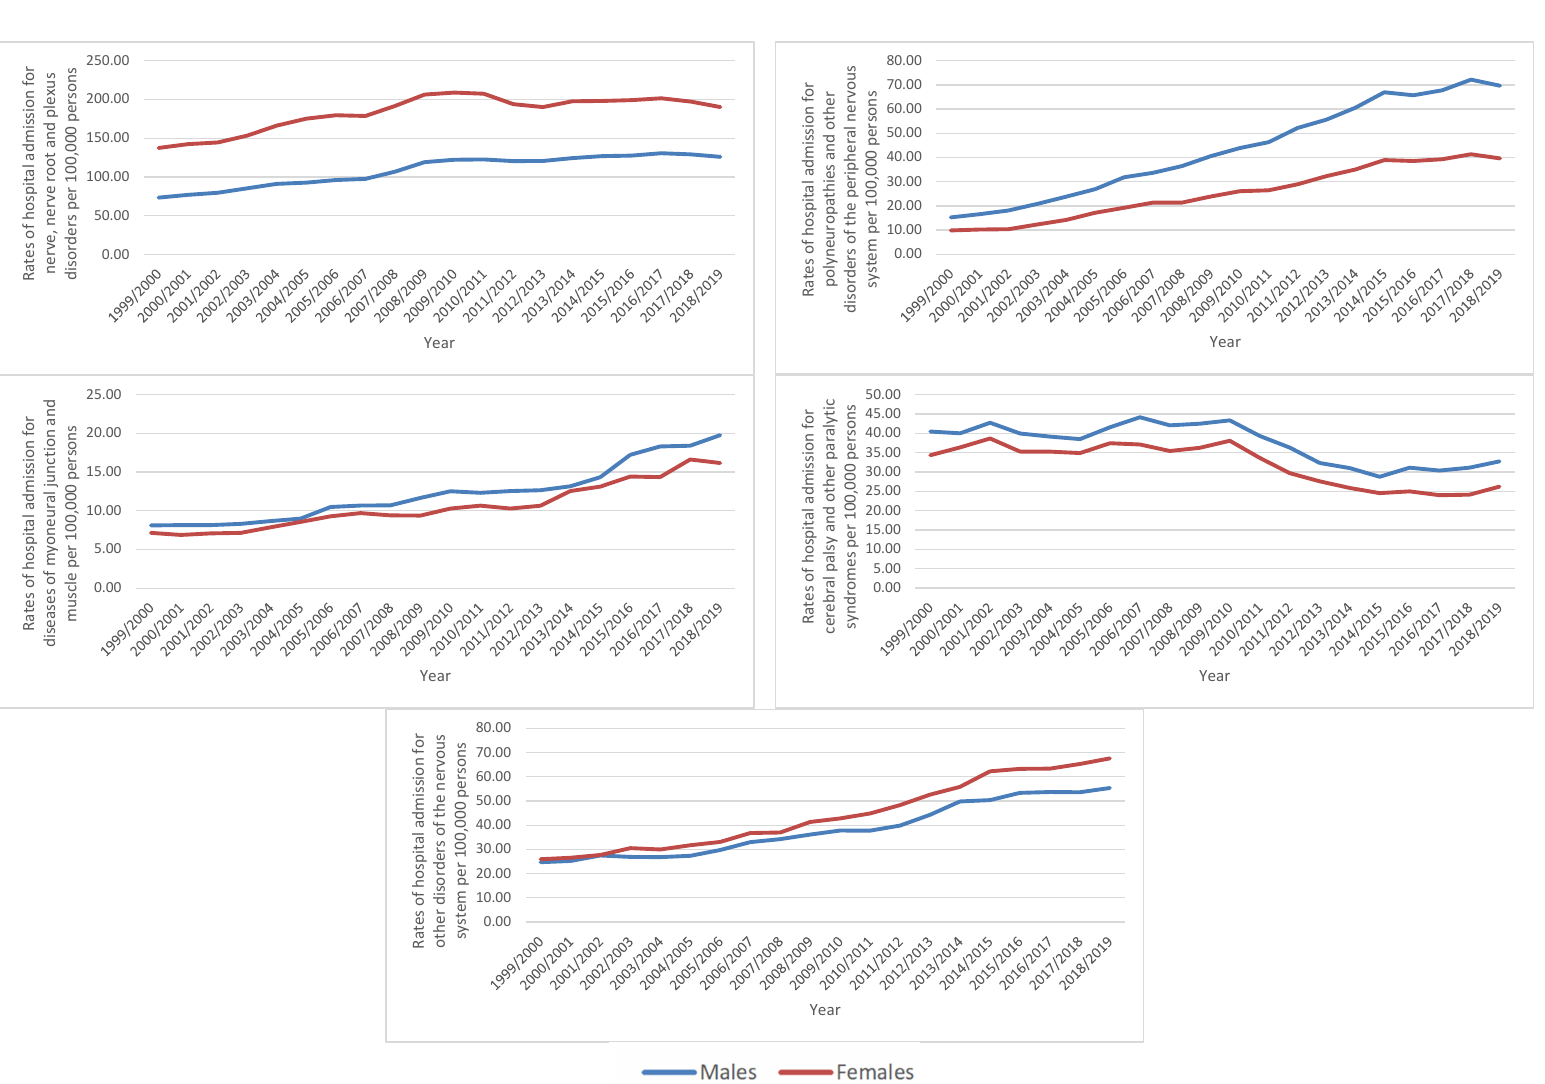
Figure 4. Hospital admission rates for diseases of the nervous system in England and Wales stratified by gender.